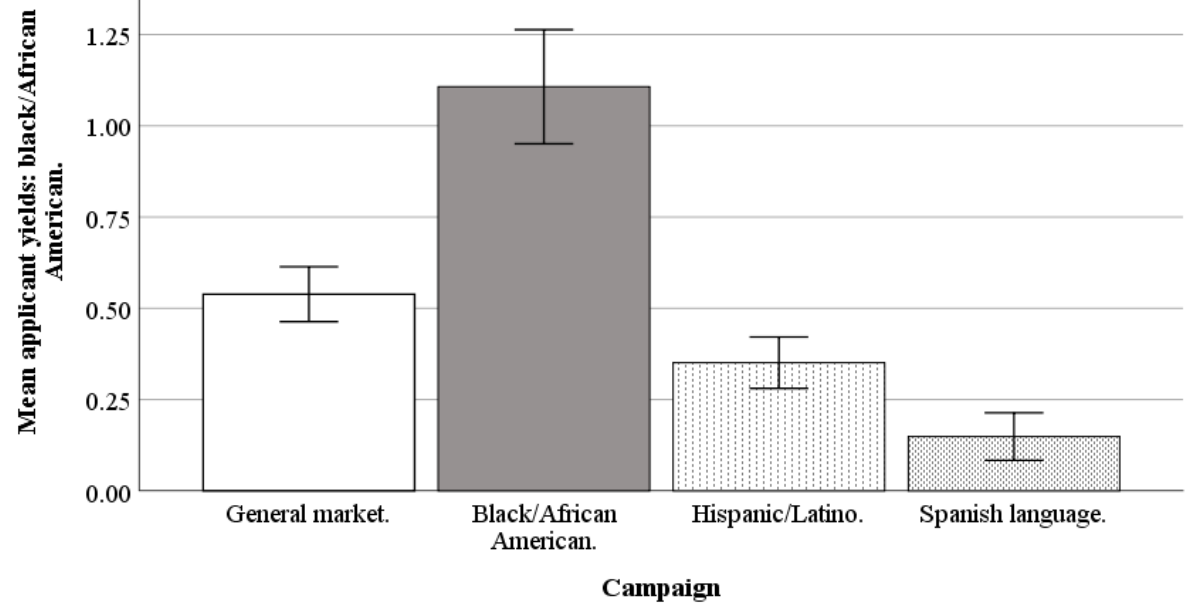
Figure 5. Mean applicant yields of blacks/African Americans for Facebook advertising